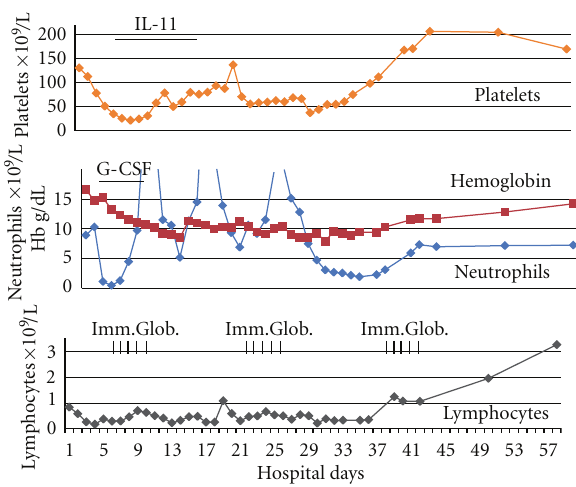
Figure 1: Blood cell counts during hospitalization. Abbreviations: IL-11: interleukin-11; G-CSF: granulocyte-colony stimulating fac- tor; Imm.Glob: human